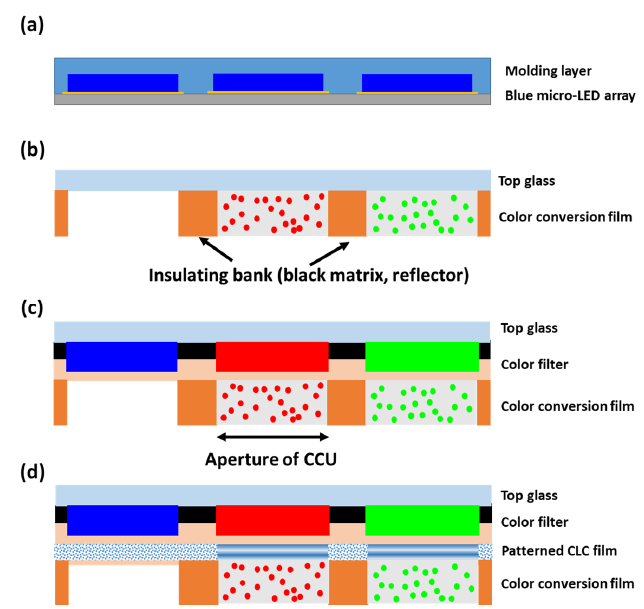
Figure 3. ( a ) Schematic diagram of the blue micro-light-emitting diode (LED) array, ( b ) the color conversion unit (CCU) consists of color conversion film only. ( c ) CCU consists of a color filter laminated on top of the color conversion film (control display system). ( d ) CCU consists of a color filter and a patterned CLC film laminated on the color conversion film (proposed display system).